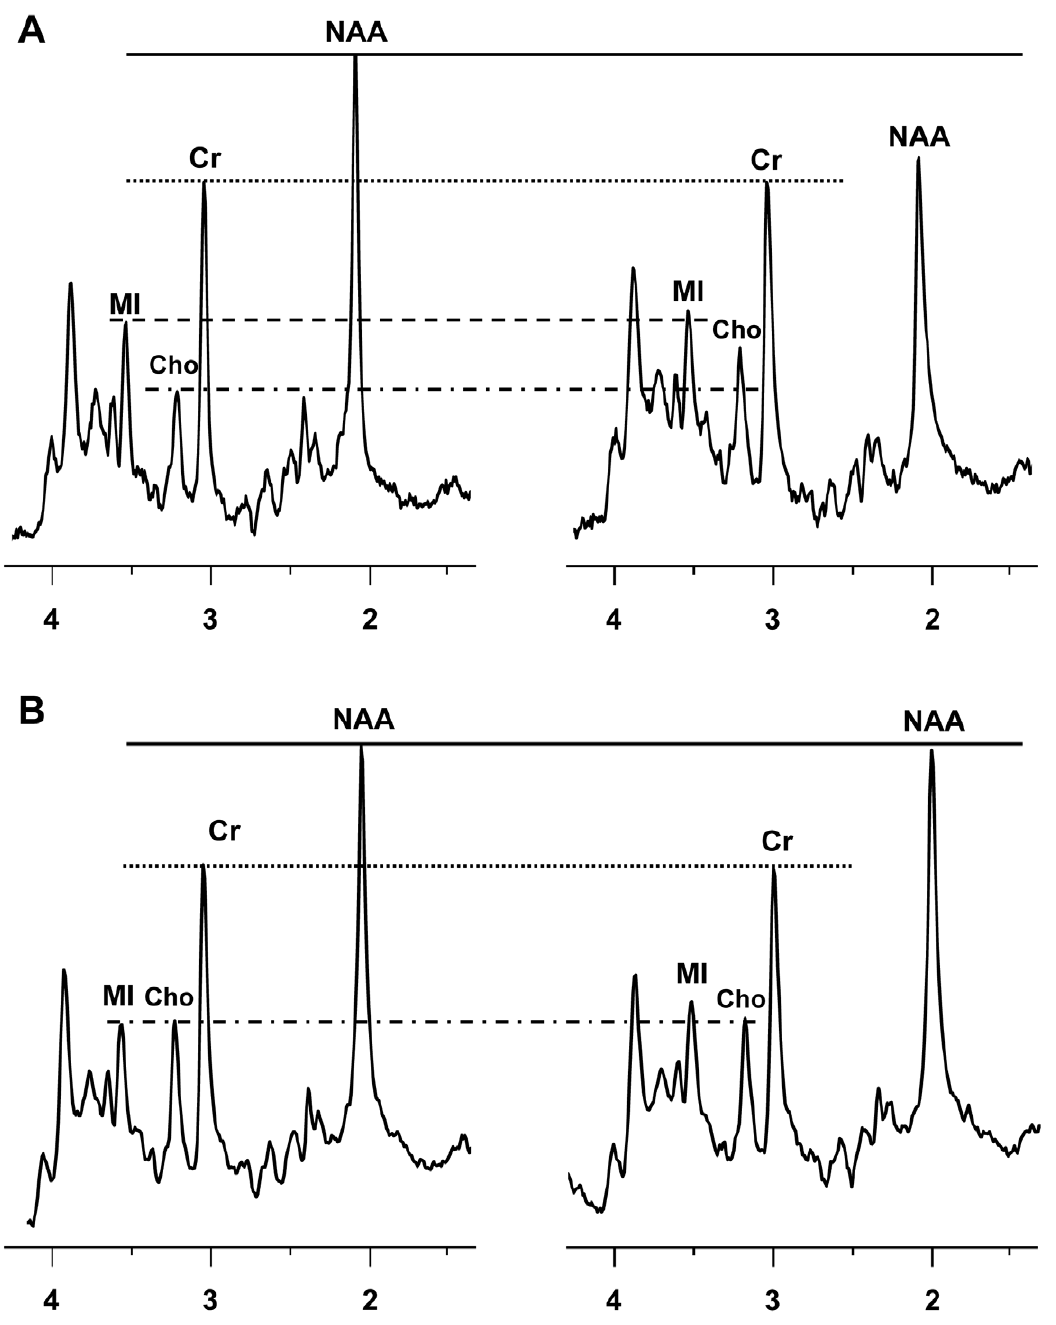
Figure 2. Comparison of 1 H MR spectra of untreated and minocycline treated macaques. ( A ) 1 H MR spectra from the white matter of a representative untreated macaque before infection and at 8 wpi. Spectra are scaled to the creatine (Cr) resonance. It can be seen from the spectra that NAA is decreased and Cho is increased at 8 wpi compared to baseline levels. ( B ) 1 H MR spectra from the white matter of a representative minocycline treated (persistently CD8-depleted) macaque before infection and at 8 wpi. Again, the spectra are scaled to the creatine resonance. It is clear that NAA/Cr has not decreased as much and also that Cho/Cr has not increased at 8 wpi. doi:10.1371/journal.pone.0010523.g002 (MI), creatine-containing compounds (referred to as Cr) and the 8 weeks post inoculation (wpi) (Figure 2A, right) and from a glutamate and glutamine concentrations (so-called Glx). Consis- minocycline treated, persistently CD8-depleted animal prior to tent with previous studies [19] the neuronal metabolism marker infection (Figure 2B, left) and at 8 wpi (Figure 2B, right). 1 H MR NAA is decreased while MI and Cho are increased in the spectra acquired with short echo time (TE = 30 ms) are charac- untreated, CD8-depleted animals at 8 wpi compared to preinfec- terized by resonances primarily arising from N-acetylaspartate and tion spectrum (Figure 2A). In contrast, the 8 wpi spectrum from N-acetylaspartylglutamate (collectively referred to as NAA), the MN-treated animal is nearly the same as the preinfection choline-containing compounds (referred to as Cho), myo -Inositol